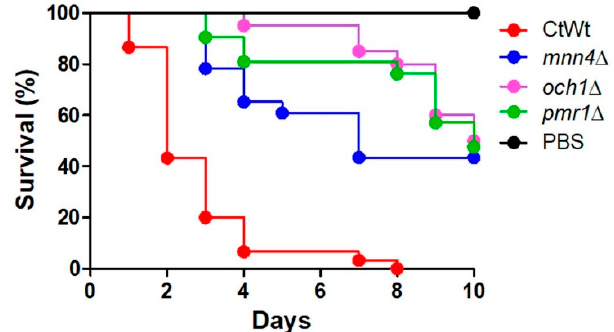
Figure 1. Mortality curves of Galleria mellonella larvae infected with Candida tropicalis WT, mnn4 Δ , pmr1 Δ , or och1 Δ null mutant strains. Each animal group contained 30 larvae (10 larvae for each experiment) and animals were infected with 2 × 10 7 yeast cells. Animal death was defined by extensive body melanization and loss of irritability, parameters that were monitored daily. PBS, control group injected only with PBS. Strains used are MYA-3404 (WT), HMY175 ( mnn4 Δ ), HMY181 ( och1 Δ ), and HMY207 ( pmr1 Δ ). The three null mutant strains showed a significant difference in the ability to kill larvae when compared to the WT strain ( p < 0.05 in all cases).